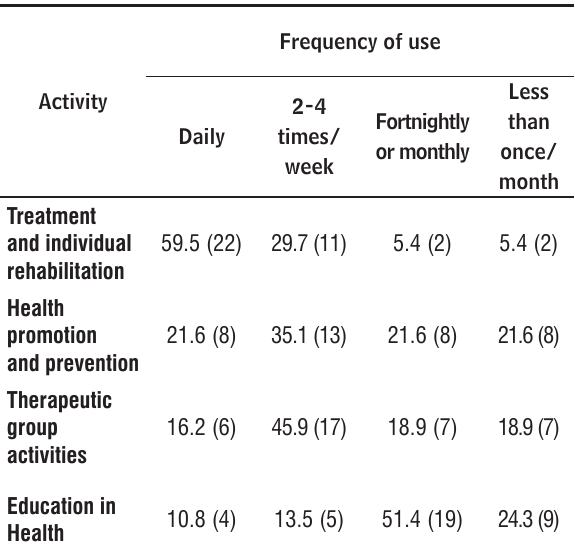
Table 3 - Type and frequency of activities carried out by physical therapists from NASF of Mato Grosso do Sul, in 2013 (n = 37)